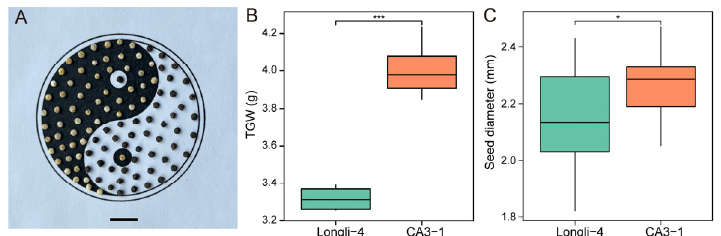
Figure 1. Grain size and weight of quinoa varieties. ( A ) Grain phenotype of two varieties. Longli-4 grains are light yellow and CA3-1 grains are black. Bar = 1 cm. ( B ) Thousand-grain weight (TGW)